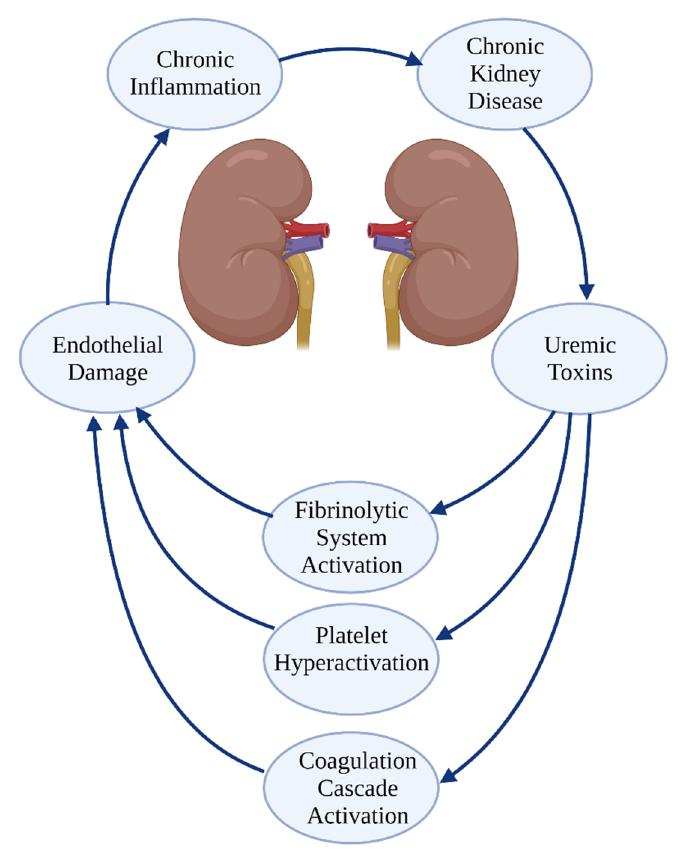
Figure 1. Hemostasis disorders in chronic kidney disease. Created with